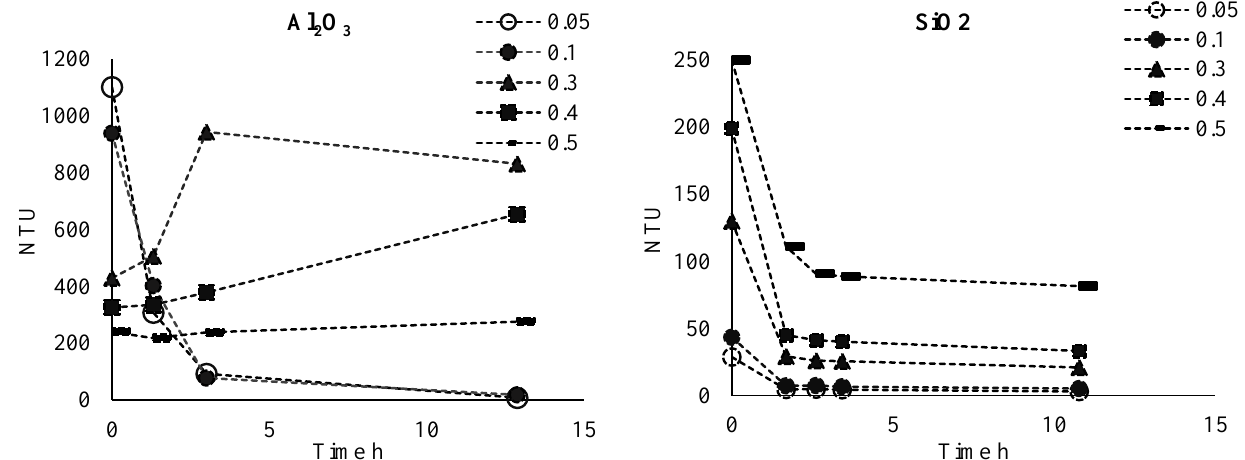
Figure 1—National Turbidity Units NTU as a function of time for alumina and silica at different starting mass fractions. Both figures are plotted with same symbols for the same weight